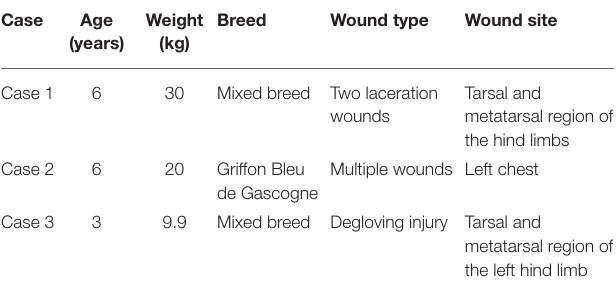
TABLE 1 | Summary of cases included in this study regarding the age, weight, breed, and type and site of the